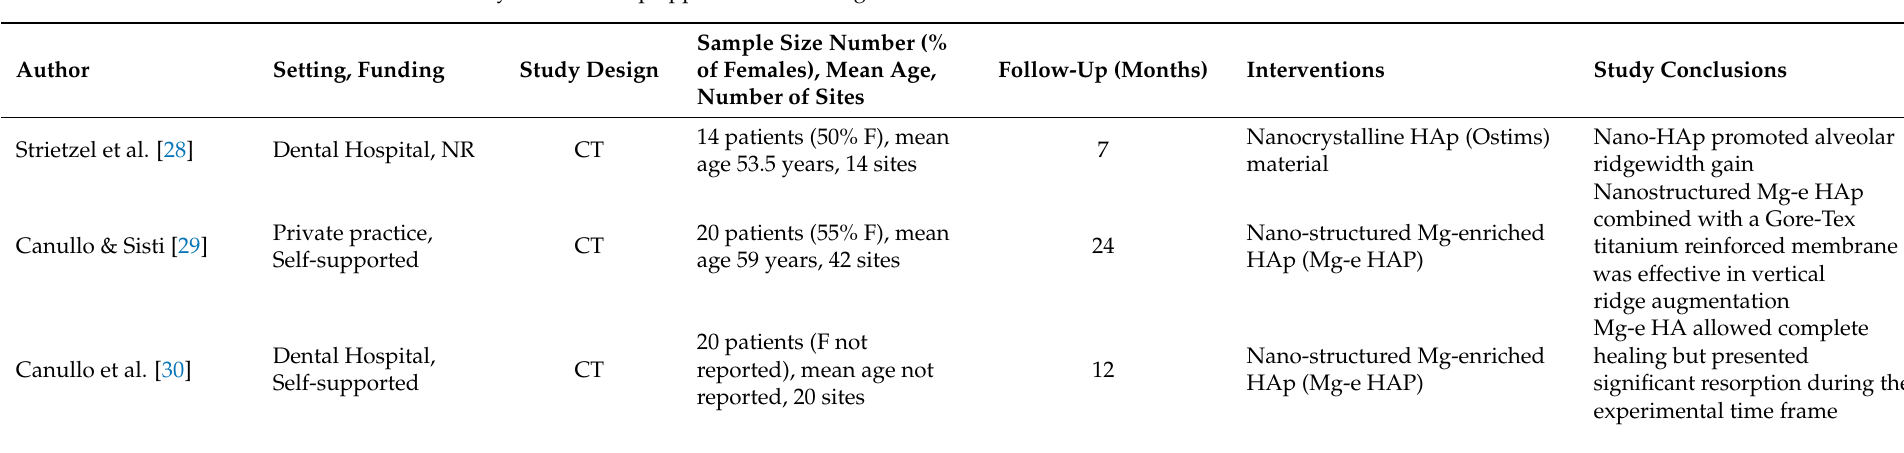
Table 4. Summary of Nano-HAp application in bone